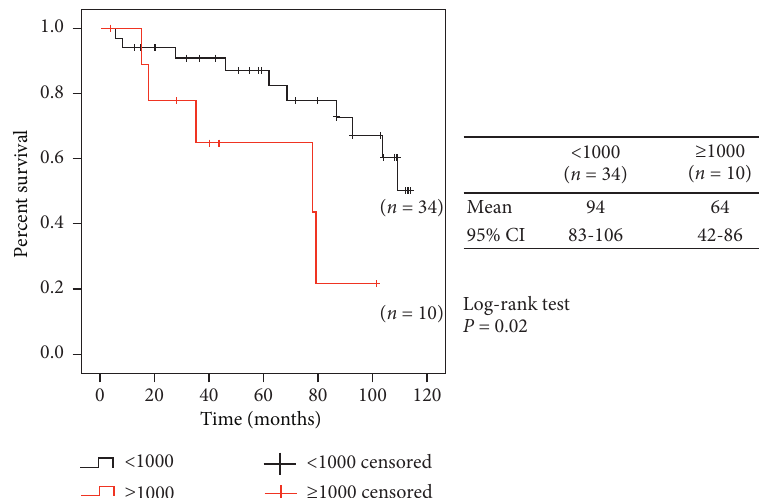
Figure 3: Kaplan–Meier survival curves for cerebrovascular and cardiovascular diseases according to serum ferritin level at baseline.